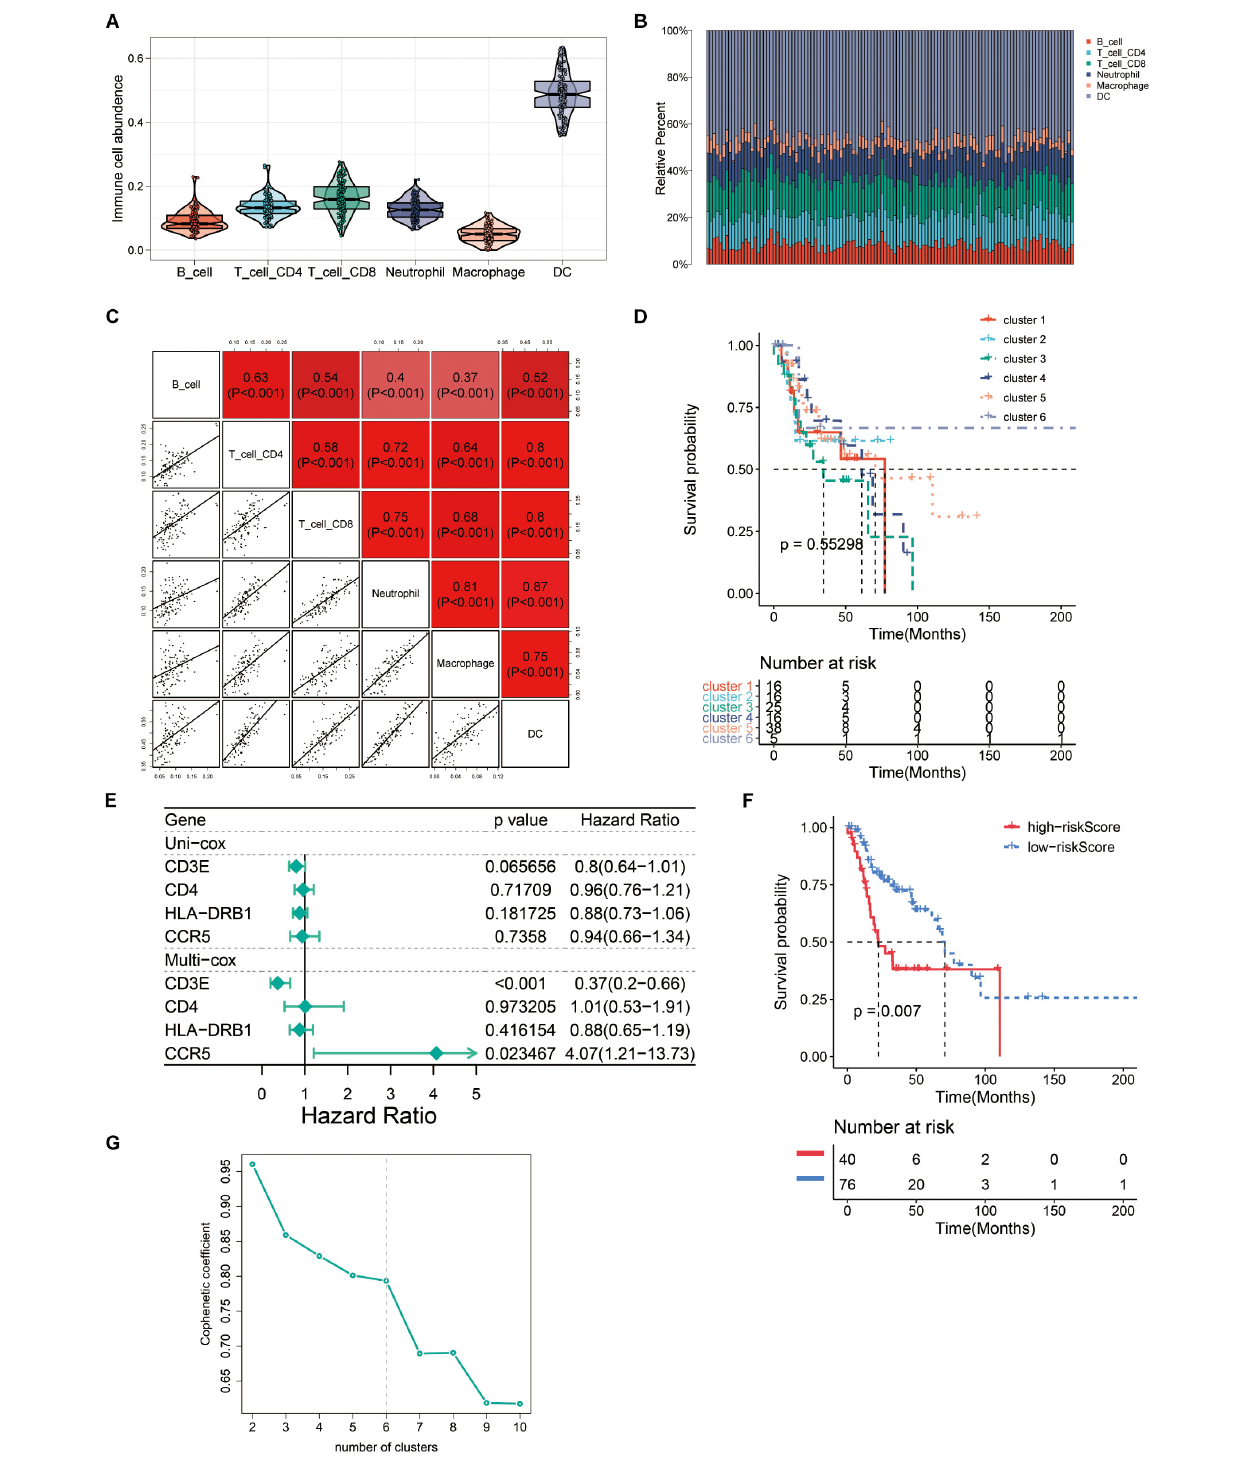
FIGURE 6 | The immune landscape of recurrent HNSCC tumor microenvironment (TME). (A) Abundance of immune infiltrating cells in recurrent HNSCC. (B) Stacked bar graph of samples arranged in the order of cluster assignment, and unsupervised clustering of all samples based on the proportion of immune cells. (C) Correlation stroma of the abundance of six immune cells. (D) Summary of survival analysis of patients in different groups. (E) Uni-Cox and Multi-Cox regression analysis of CCR5, CD3E, CD4, and HLA-DRB1 four genes. (F) Survival analysis of CCR5, CD3E, CD4, and HLA-DRB1 four genes in the high-risk group and the low-risk group. (G) Optimal number of clusters by unsupervised clustering analysis.